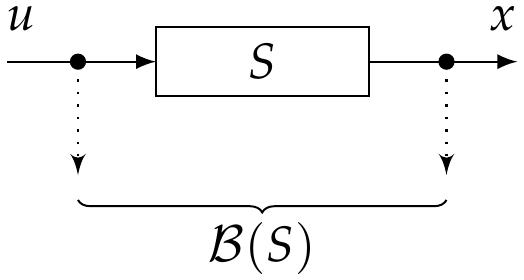
Figure 1. Illustration of the behaviour of a system S